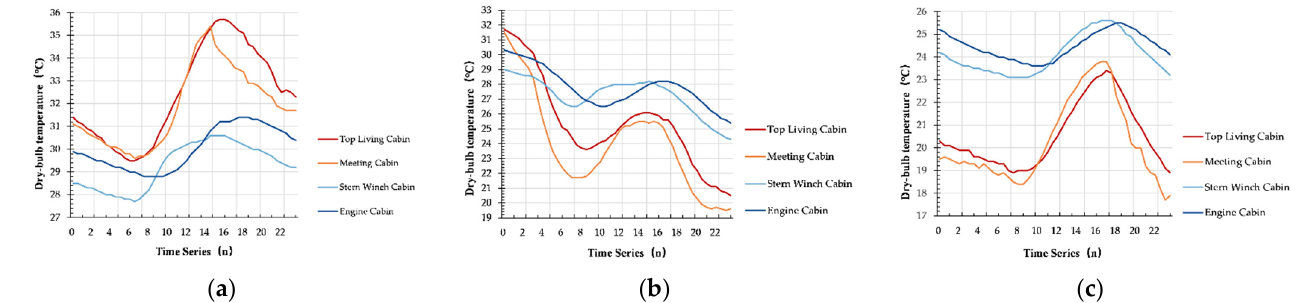
Figure 11. Dry-bulb temperatures in the ship on ( a ) 4, ( b ) 5, and ( c ) 6 October